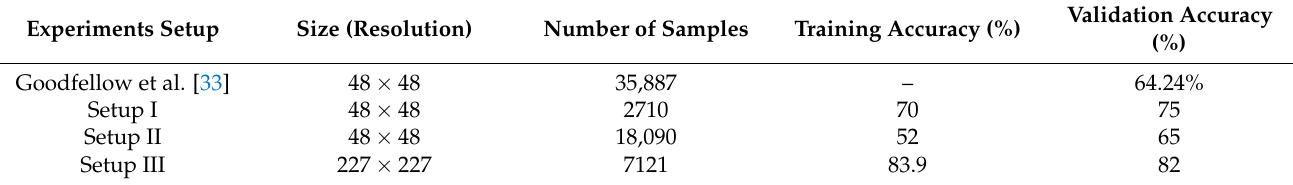
Table 5. Loss and accuracy values of training and validation for